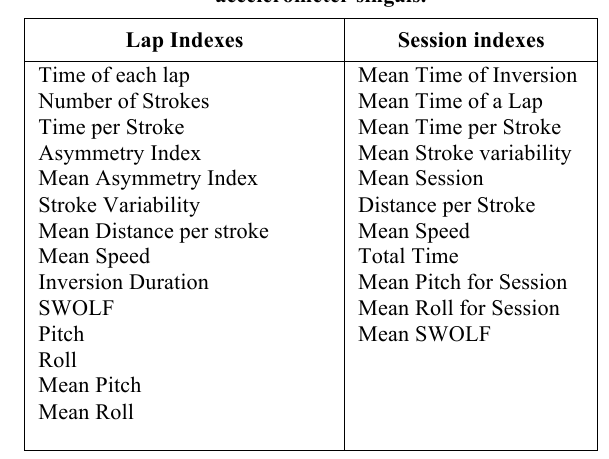
Table 1. Indexes obtained by the signal processing of the accelerometer singals.